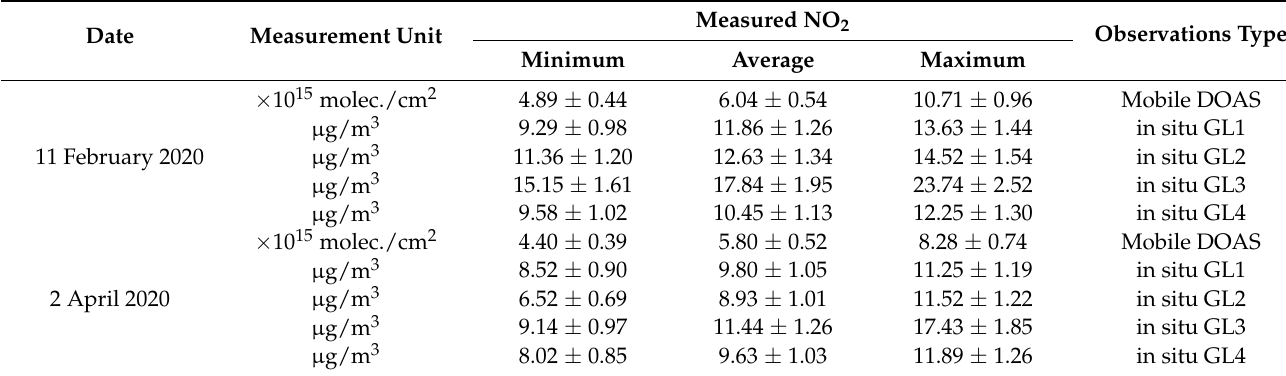
Table 3. The NO 2 detected by AQMS and mobile DOAS (DSCD) on 11 February 2020 and 2 April 2020 during the time interval 09–13 LT.